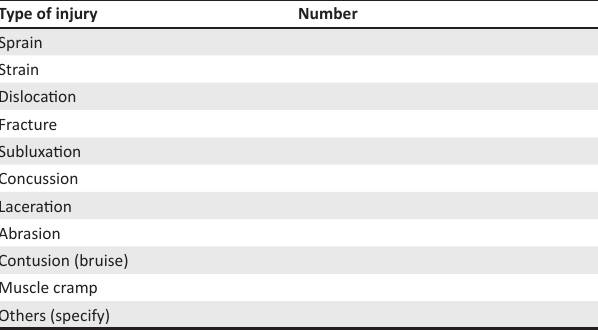
TABLE 2-A2: Initial treatment information.